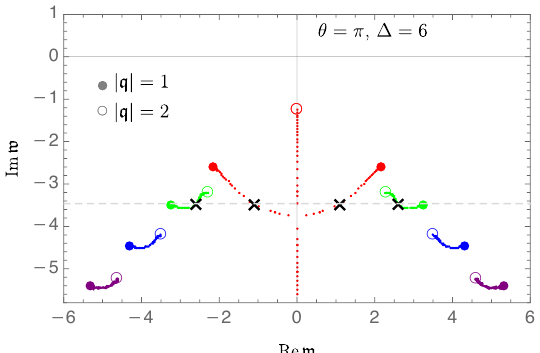
Figure 2 . This figure shows the same QNMs as figure 1, however, now in the complex frequency plane. Along the trajectories, | q 2 | changes from 1 (dots) to 2 (circles). This range is chosen in order to resolve the apparent collision between the red and green pole in figure 1 and the apparent branch point of the red curve in that same figure, both occuring near Im w ≈ − 3 . 5 . All modes are shown for the fixed phase θ = π